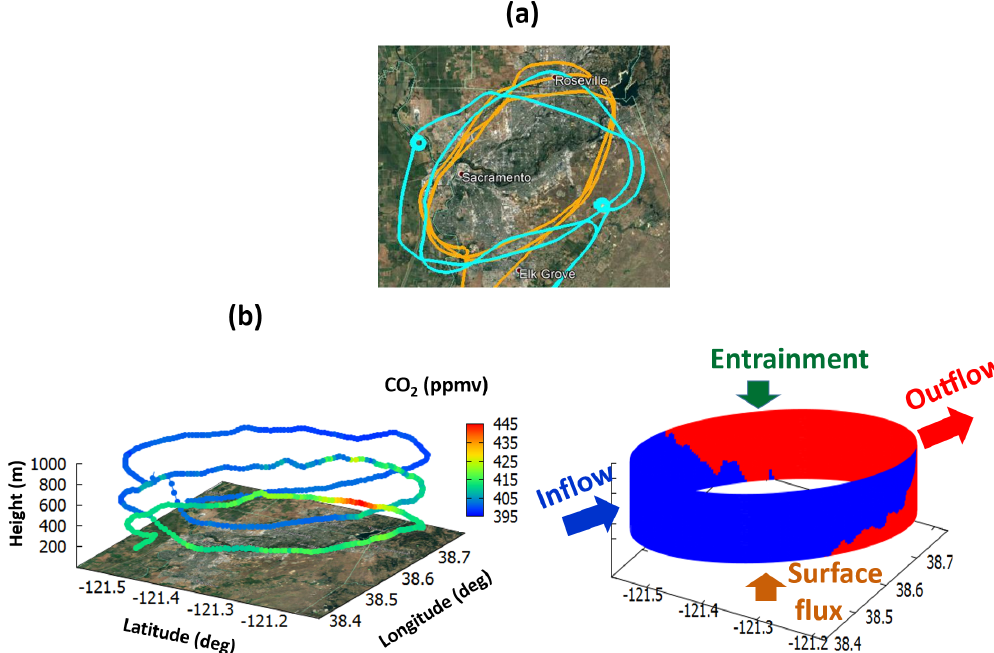
Figure 1. (a) Map of AJAX flight tracks on 18 November 2013 (orange) and 29 July 2015 (cyan) plotted in Google ™ Earth. (b) Vertical measurements of CO 2 mixing ratio on 18 November 2013, and (c) simple illustration of airflow (kgm − 2 s − 1 ) passing through the cylinder (over Sacramento). The color represents the air mass flux (density, kgm − 3 ; multiplied by wind vector, ms − 1 ) normal to the cylinder. The blue and red represent inflow and outflow, respectively. The vertical mass transfer through the top and bottom are referred to as the entrainment and surface flux,